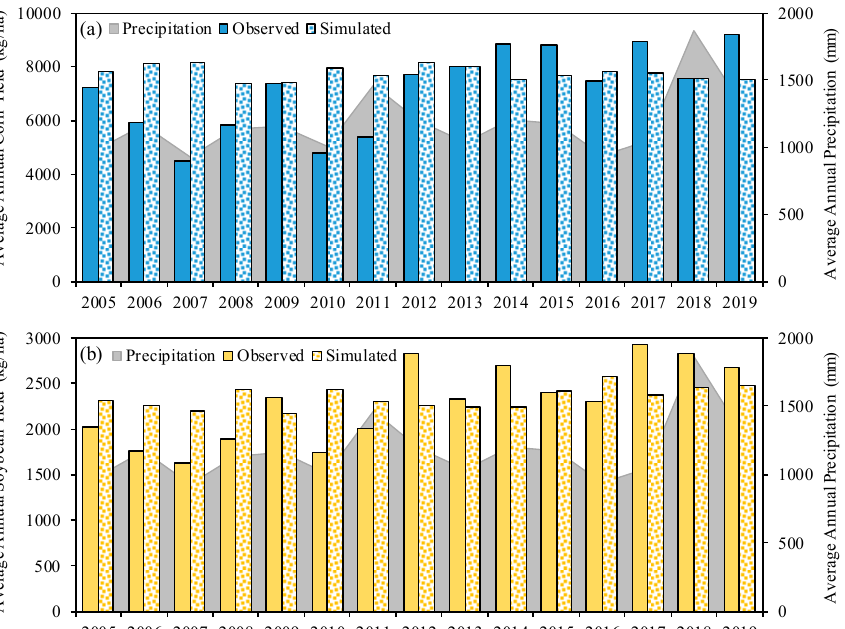
Figure 4 is showing the comparison between observed and simulated crop yields for the calibration (2005–2014) and validation (2015–2019) periods. During calibration, the simulated average crop yields for corn (7817.3 kg/ha) and soybean (2282.3 kg/ha) were higher than the observed yields of 6553.9 kg/ha and 2123.5 kg/ha, respectively. As a result, during calibration, the RMSE for corn and soybean were 1596.8 kg/ha and 373.2 kg/ha, respectively. However, the simulated corn and soybean yields during validation were closer to the observed data with a smaller RYR of 8.78% and 6.23%, respectively. RMSE was also much lower during validation than the calibration period (610.4 kg/ha and 191.3 kg/ha for corn and soybean, respectively). The RYR for corn and soybean indicates that the SWAT model overestimated (negative RYR in Table 4) the crop yield during calibration and underestimated (positive RYR in Table 4) it during the validation period. This result also indicates that over the years the fertilizer uses increases in this area. However, study, a fixed amount of fertilizer was used, which resulted in these RYR variations.